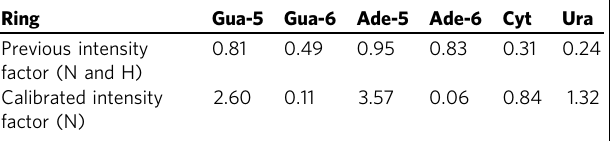
Table 1 Ring-current intensity factors used to calculate RC